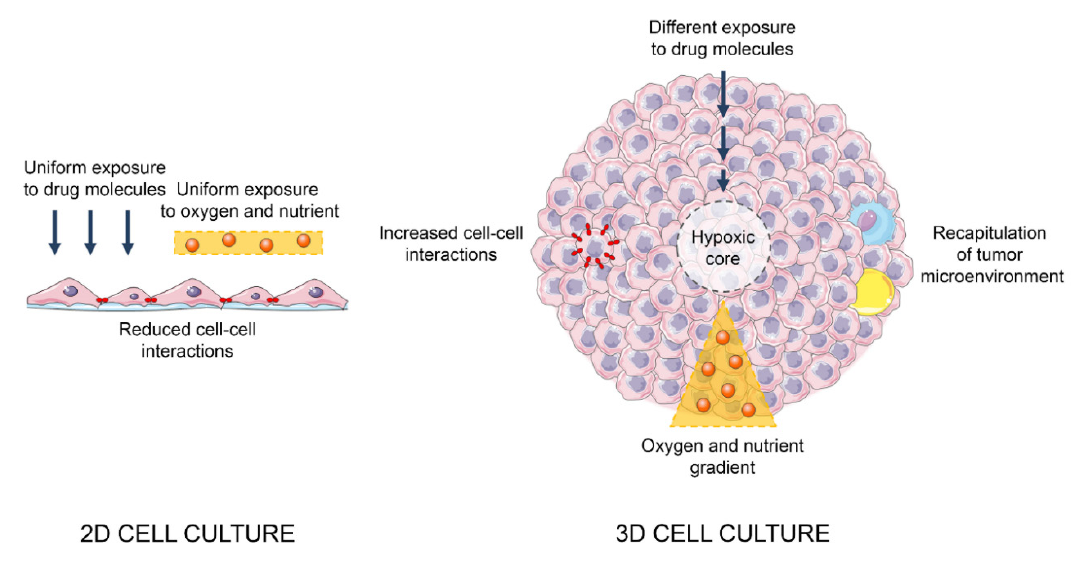
ff erences between 2D and 3D cell Figure 1. Main differences between 2D and 3D cell cultures. Figure 1. Main di